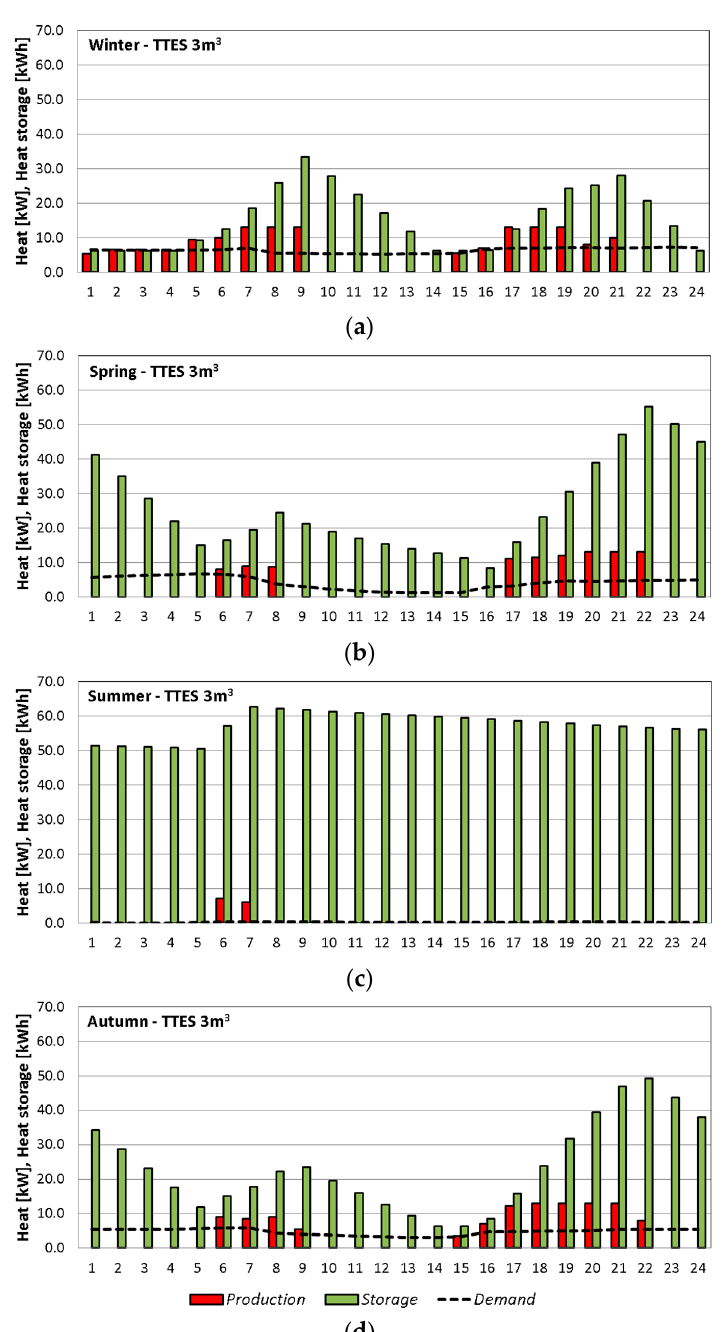
Figure 10. Comparison of the heat demand, production and storage in the mCHP system which uses the new algorithm, for each representative day of ( a ) winter, ( b ) spring, ( c ) summer, and ( d ) autumn.